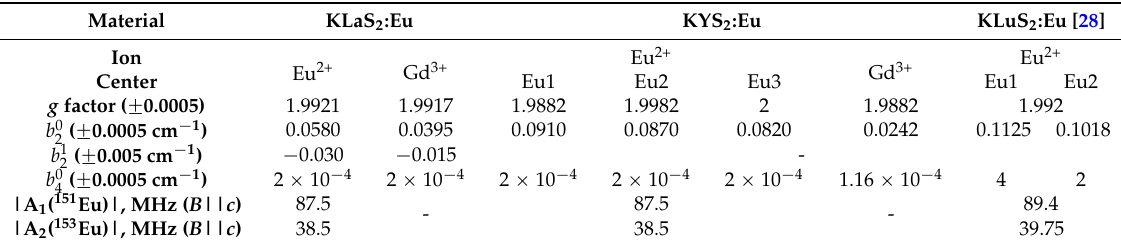
Table 5. Spin-Hamiltonian parameters of the Eu 2+ /Gd 3+ ions in the different materials. Material KLaS 2